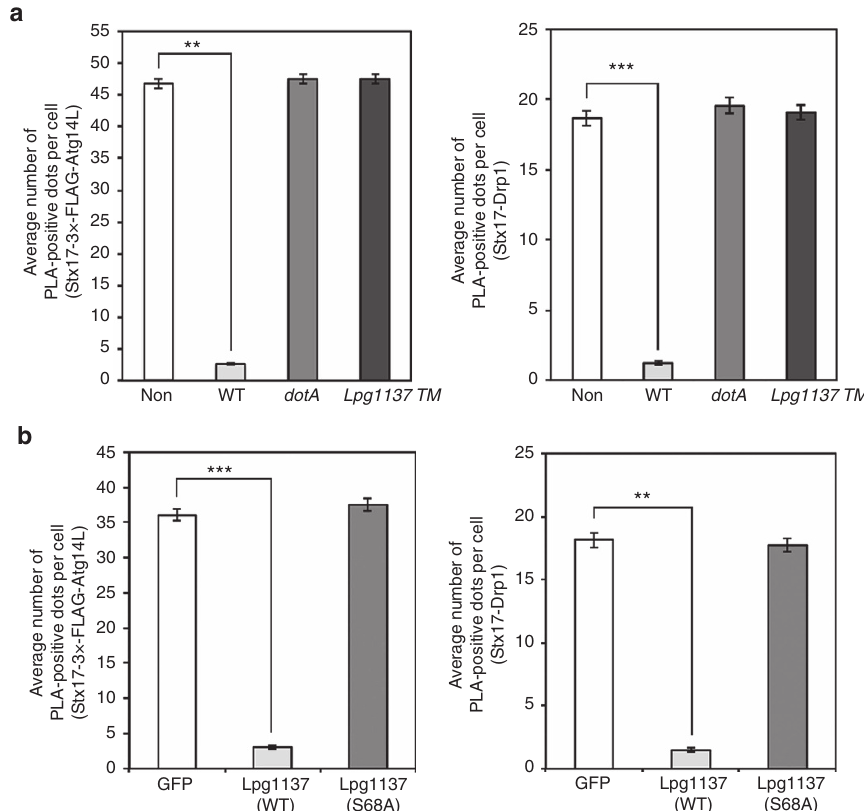
Figure 5 | Lpg1137 eliminates the interactions of Stx17 with Atg14L and Drp1. ( a ) HeLa-Fc g RII cells expressing 3 (cid:2) -FLAG-Atg14L (left) or HeLa-Fc g RII cells (right) were non-infected or infected with Legionella at an MOI of 50 for 4h. Before fixation, HeLa-Fc g RII cells expressing 3 (cid:2) -FLAG-Atg14L were incubated with EBSS for 2h to induce autophagy. Cells were fixed and subjected to PLA using the indicated pairs, and the number of PLA dots was scored. Values are means ± s.e.m ( n ¼ 3). ** P o 0.001 and *** P o 0.0001 as compared with noninfection. ( b ) HeLa-Fc g RII cells were transfected with a plasmid encoding GFP, GFP-Lpg1137 wild-type (WT) or GFP-Lpg1137 S68A with or without 3 (cid:2) -FLAG-Atg14L. At 24h after transfection, cells expressing GFP constructs and 3 (cid:2) -FLAG-Atg14L were incubated with EBSS for 2h and fixed, or cells expressing only GFP constructs were fixed. PLA was performed using the indicated pairs. Values are means ± s.e.m. ( n ¼ 3). ** P o 0.001 and *** P o 0.0001 as compared with